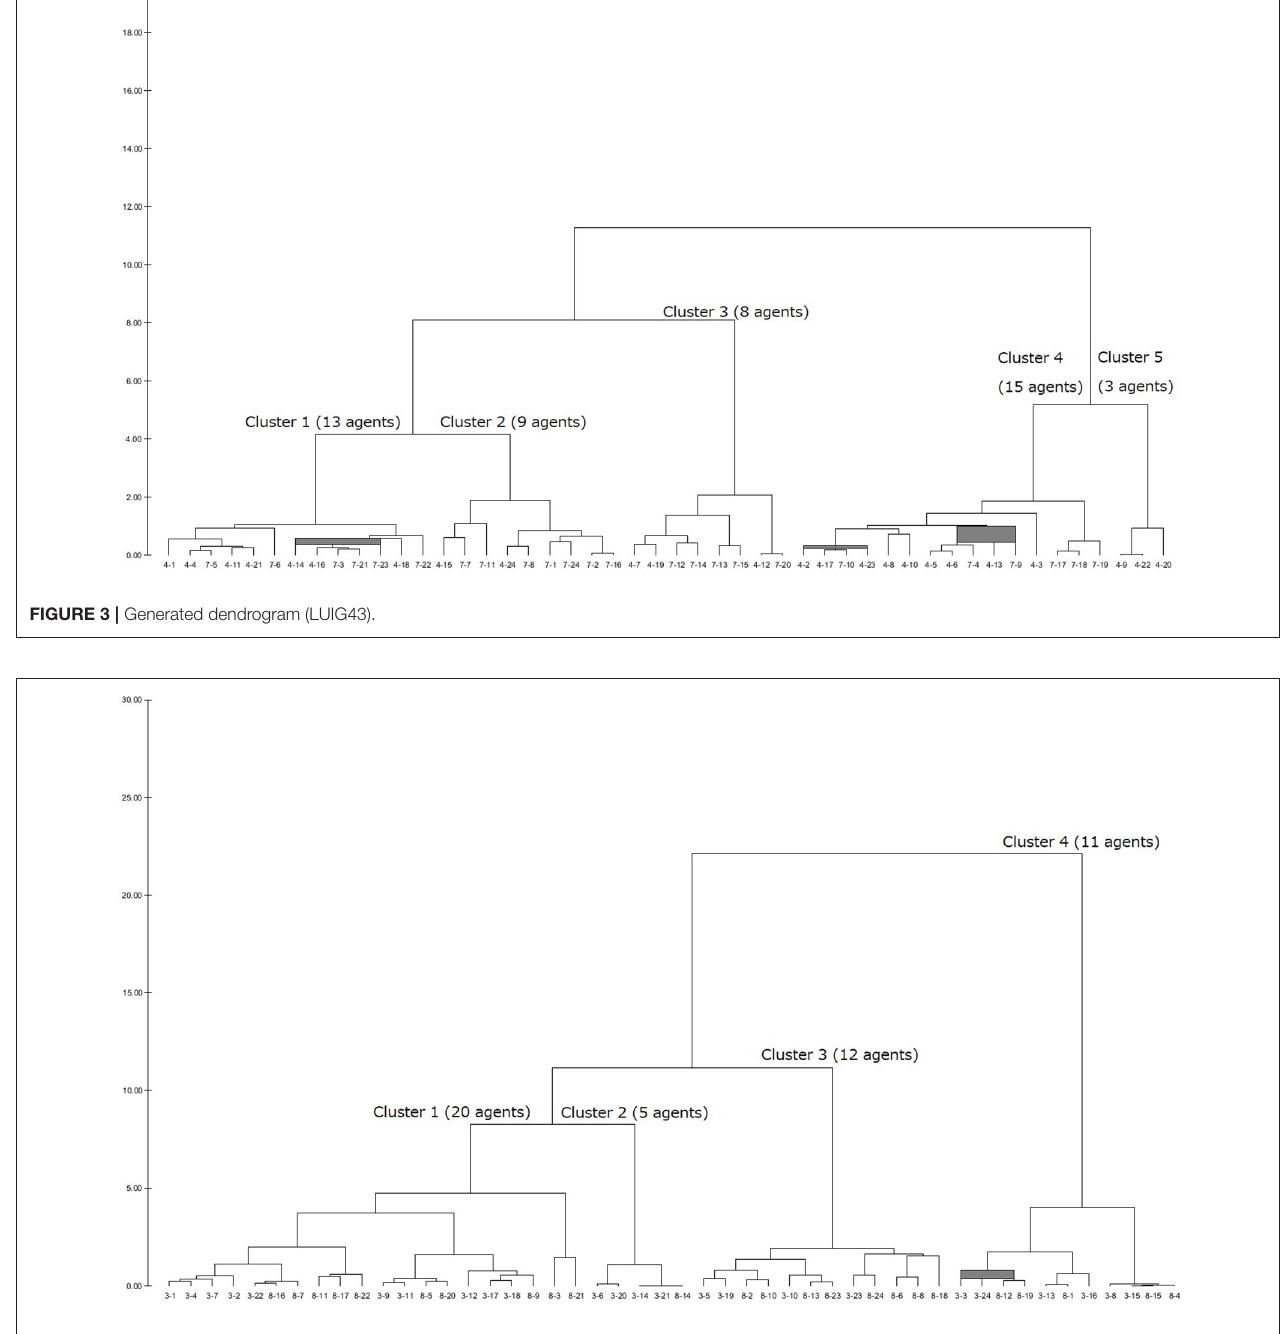
4. The initial propensities of each agent in each game are the ones estimated by the maximum likelihood method. In other words, the agents learn and update their belief by using the data of Yamada and Hanaki [1] before they start to